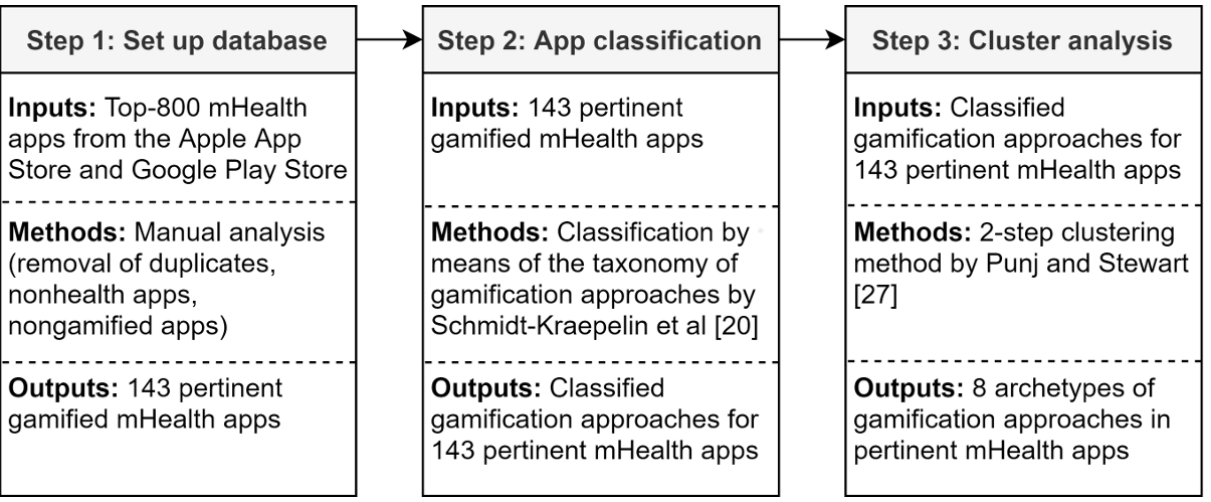
Figure 1. Overview of the 3-step research